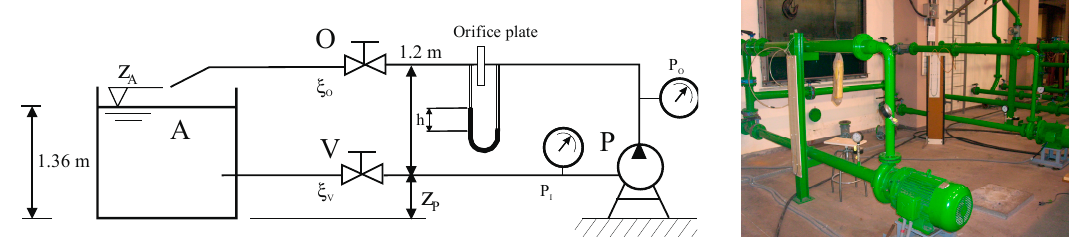
Figure 1. Available set-up for experimental measurements: sketch ( left ) and real image ( right